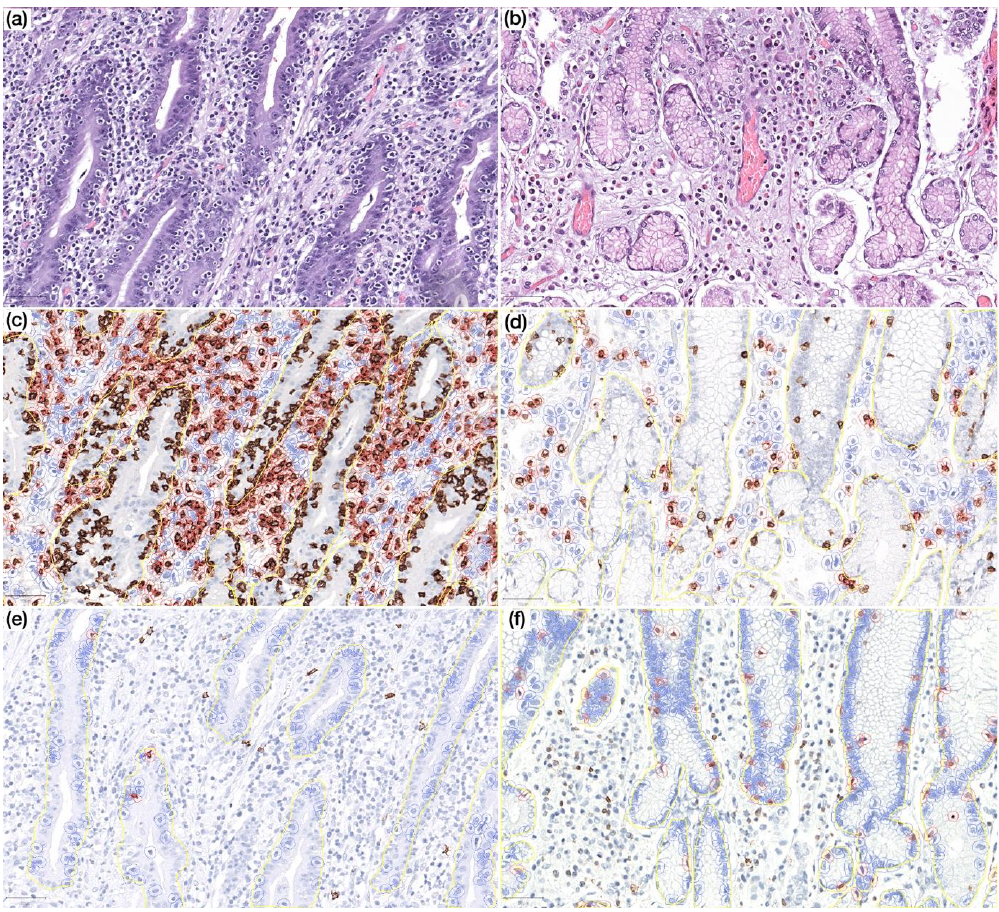
Figure 4. ( a ) Prominent lymphocytic gastritis in non-neoplastic mucosa distant from gastric cancer in a CVID patient (HE, 200×); ( b ) non-neoplastic mucosa distant from gastric cancer in a non-CVID patient without features of lymphocytic gastritis (HE, 200×); ( c,d ) non-neoplastic mucosa distant from gastric cancer in a CVID patient ( c ) showing higher CD8+ lymphocyte count in lamina propria as compared to a non-CVID patient ( d ) (IHC, 200×); ( e,f ) non-neoplastic mucosa distant from gastric cancer in a CVID patient ( e ) showing lower CD20+ lymphocyte count in the intraepithelial compartment as compared to a non-CVID patient ( f ) (IHC, 200×). Positive cells are highlighted by a red circle.